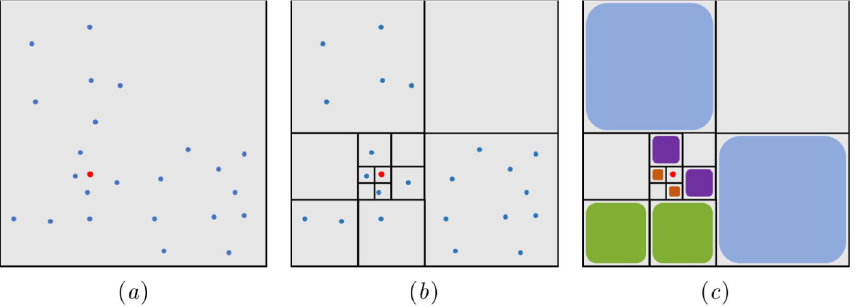
Fig 2. Schematic diagram of the nested grid algorithm. (a) Distribution of vortex particles; the red point is the inquiring position, p , and the blue points are the vortex particles. (b) Structure of the nested grid. (c) Distribution of super vortex particles.